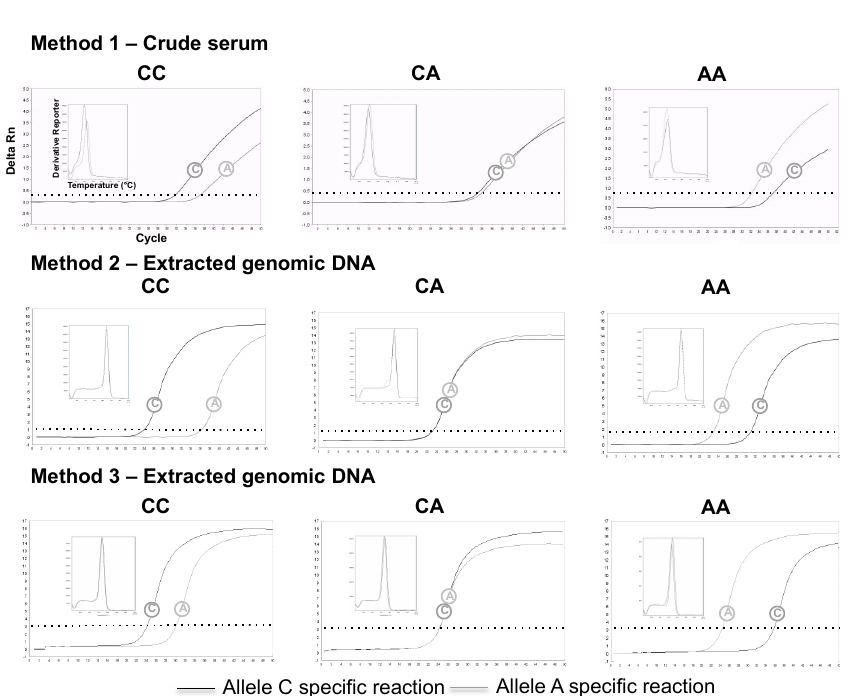
Figure 6. Representative rs3802842 genotyping using method 1 (2 µ L of crude serum separated 4 h after the capillary blood collection), 2 and 3.